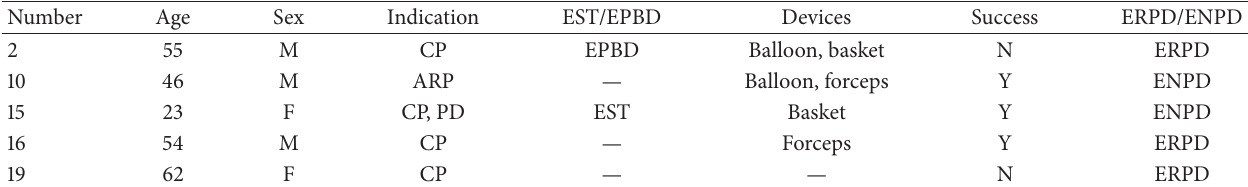
Table 3: Characteristics of the patients who developed